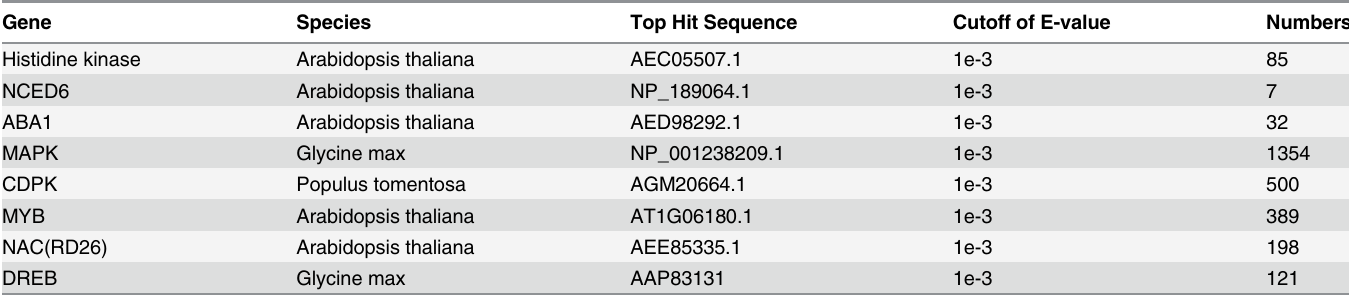
Table 2. Main orthologs involved in abotic stress